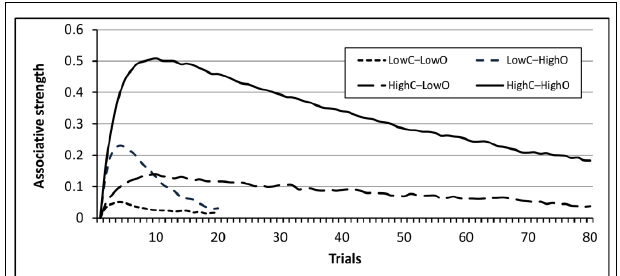
FIGURE 1 | Results of a computer simulation of the four experimental conditions presented by Blanco et al. (2013, Experiment 1) using the Rescorla–Wagner learning algorithm. The simulation was conducted using the Java simulator developed by Alonso et al. (2012). For this simulation, the learning rate parameters were set to α cause = 0.3, α β β (cid:24) context = 0.1, outcome = outcome =